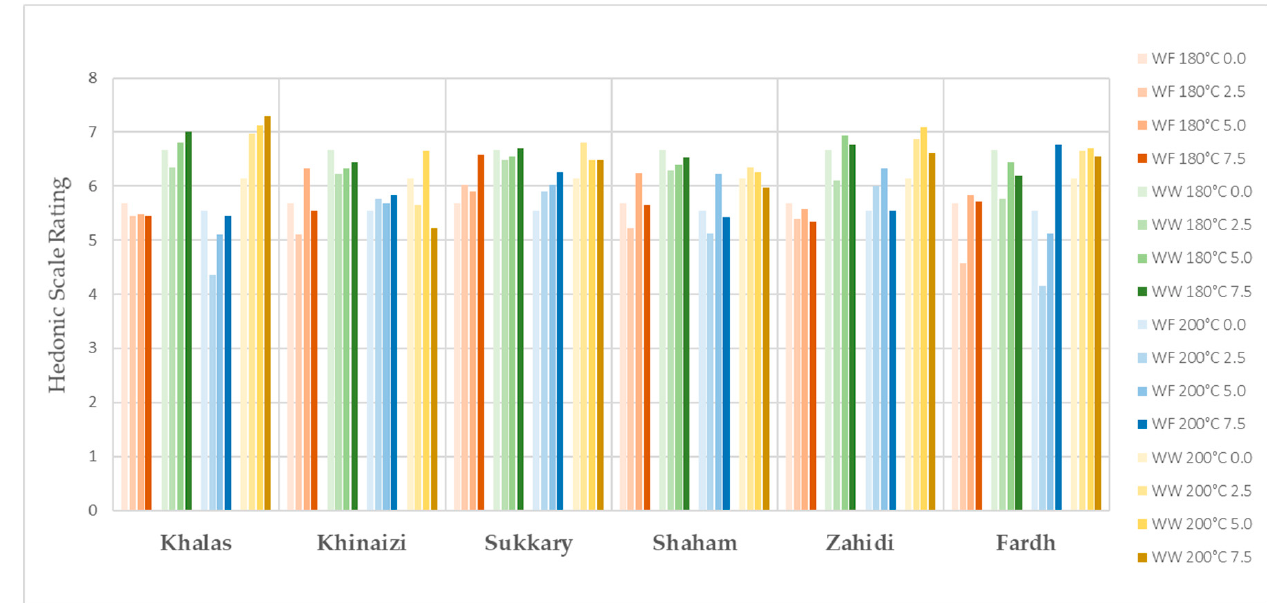
Figure 2. Colour evaluation for date seed composite cookies.